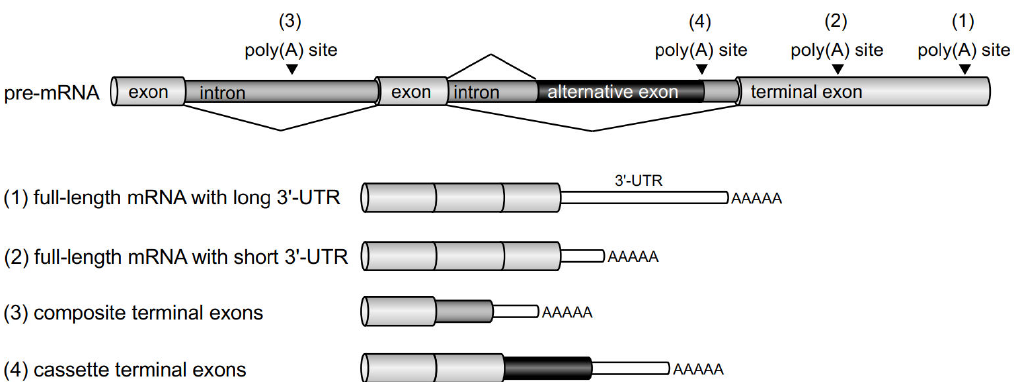
Figure 1. Di ff erent mRNA isoforms generated by alternative polyadenylation. Splicing is indicated by the lines in pre-mRNA diagrams. The 3 (cid:48) -UTRs of mRNA isoforms are depicted by white boxes. Additional or alternative coding sequences of mRNA isoforms are shown by black boxes. (1, 2) Poly(A) signals in the terminal exon are used to generate full-length mRNAs with di ff ering 3 (cid:48) -UTR lengths. The full-length mRNA isoform with a longer 3 (cid:48) -UTR (1) contains more regulatory elements than the isoform with a shorter 3 (cid:48) -UTR (2). (3) The inhibition of splicing of an upstream intron results in the inclusion of the adjacent intron and the use of a poly(A) signal within introns. (4) The alternative splicing and usage of alternative poly(A) signals in the alternative exon generates a transcript containing di ff erent terminal exon and 3 (cid:48) -UTR